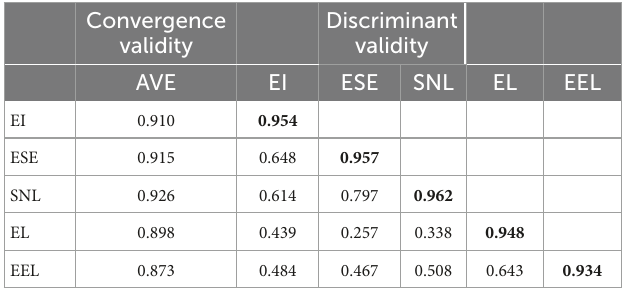
TABLE 3 Discriminant validity.